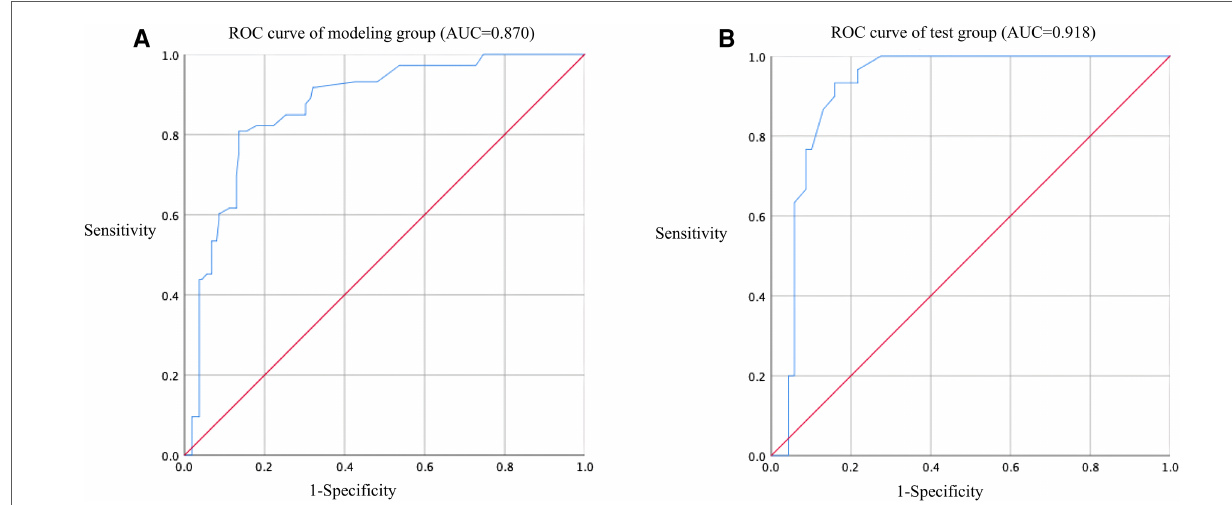
FIGURE 3 ROC curve of nomogram model for predicting the risk of lower extremity DVT detachment in orthopedic patients. ( A ) ROC curve of modeling group (AUC=0.870); ( B ) ROC curve of test group